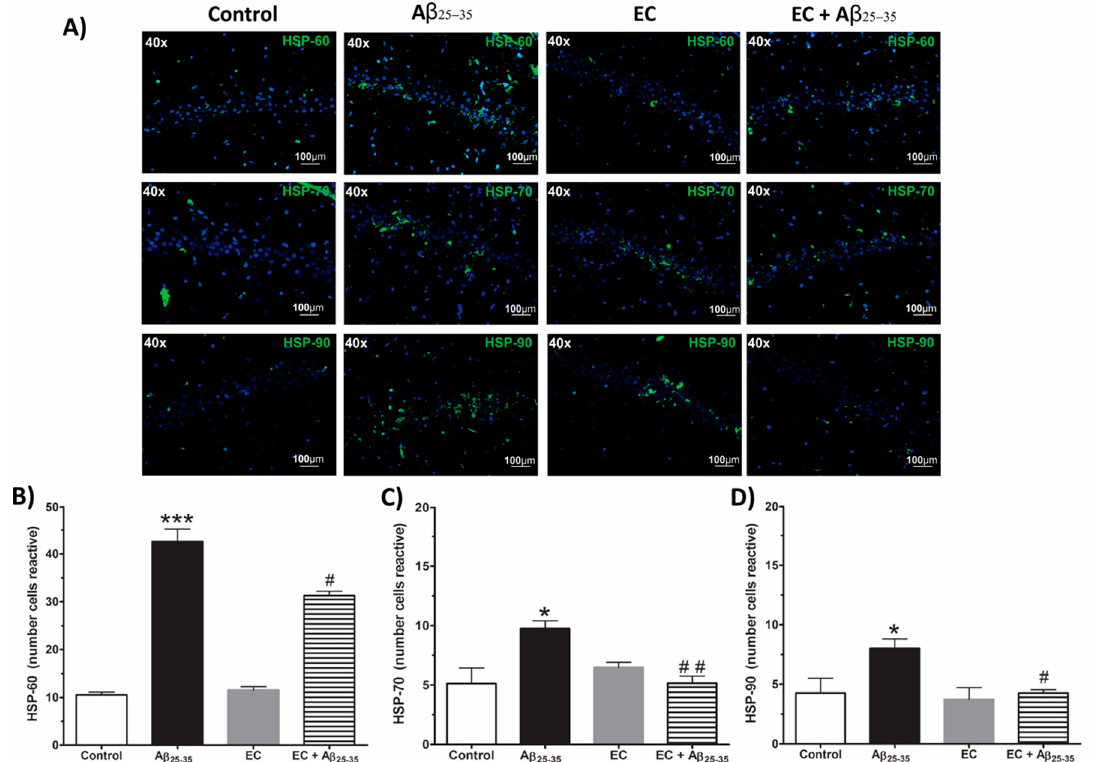
Figure 4. E ff ect of epicatechin on immunoreactivity of HSPs in CA1 subfields of the Hp of rats injected with A β 25–35 . In ( A ) we observed the immunoreactivity (green color) for HSP-60, HSP-70, and HSP-90 in the CA1 subfield of the Hp of rats with di ff erent treatments: control, A β 25–35 , EC, and EC + A β 25–35 . The epicatechin treatment decreases the number of immunopositive cells to HSP-60 ( B ) HSP-70 ( C ) and HSP-90 ( D ) in the Hp of rats injected with A β 25–35 ( A ). The mean ± SE is plotted. Data were analyzed with one-way ANOVA and post-test Bonferroni test (* p < 0.05 and *** p < 0.001) comparing all groups with respect to the vehicle group. (# p < 0.05 and ## p < 0.01) compared the A β 25–35 versus EC + A β 25–35